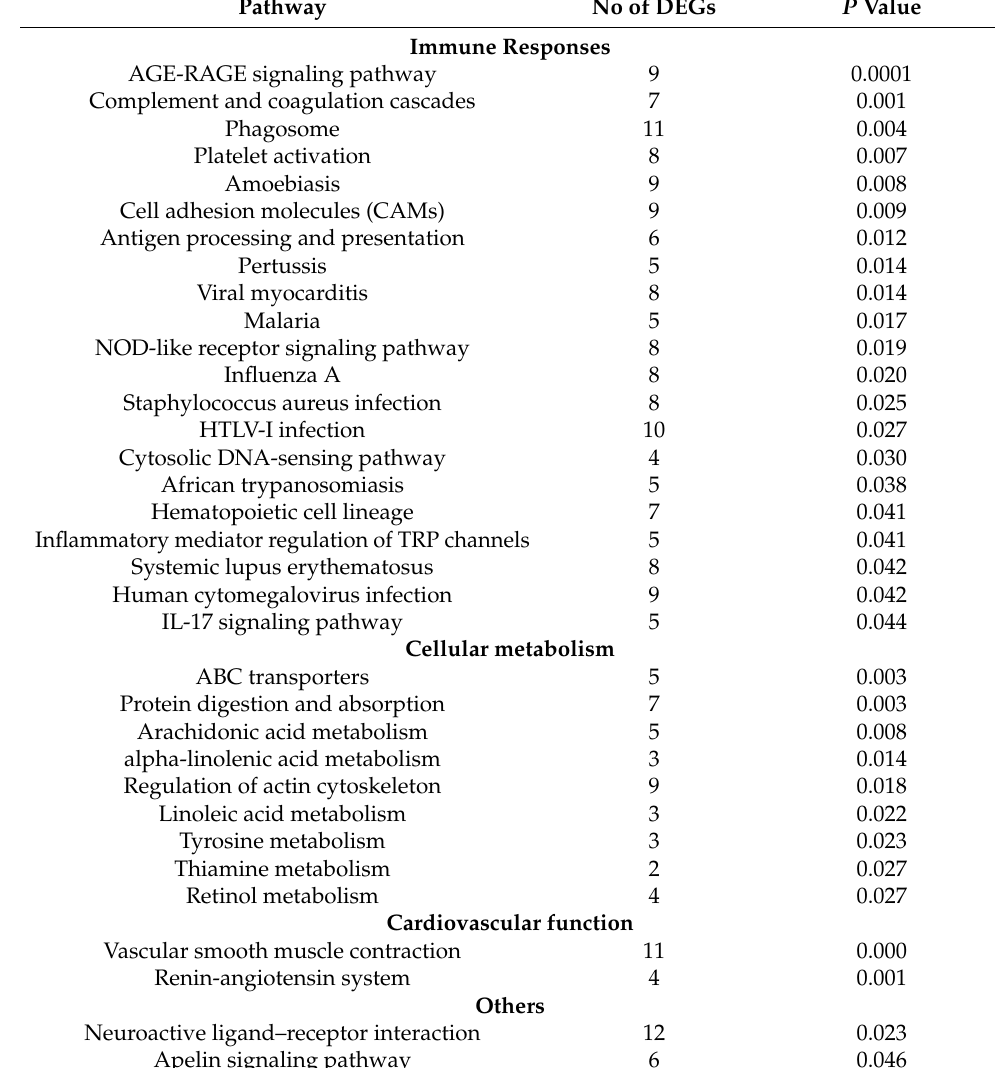
Table A2. KEGG enriched pathways (All DEGs from naïve control vs.